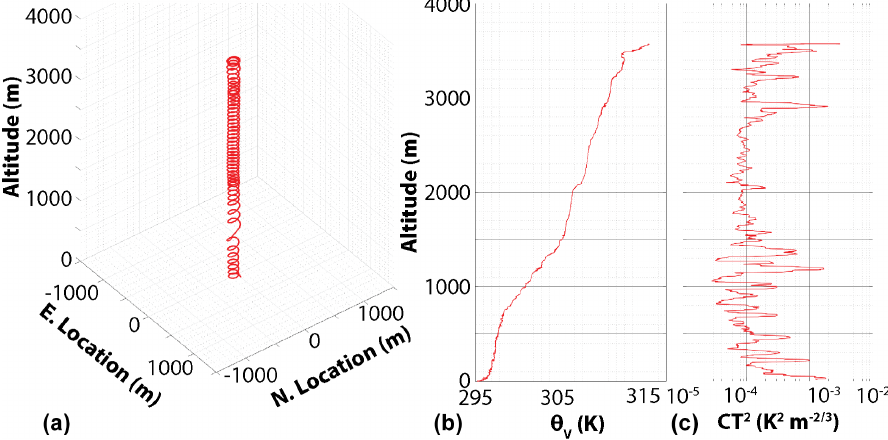
Figure 7. DH2 flight trajectory example from SHUREX 2017 (a) along with vertical profiles of virtual potential temperature (b) and tem- perature structure constant (c) derived from post-flight data